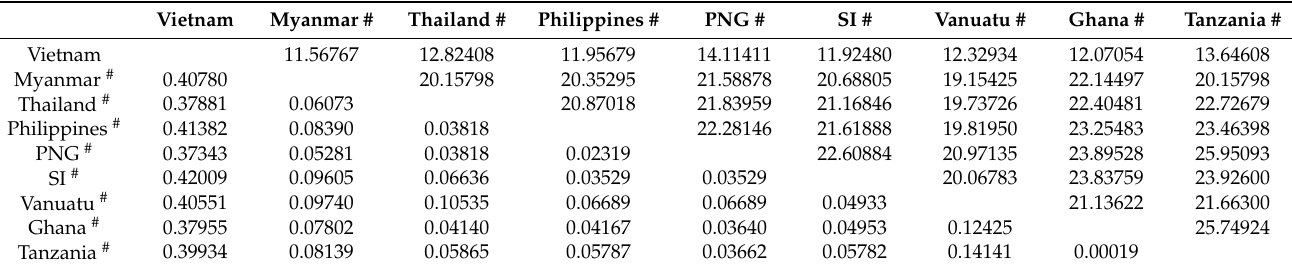
Table 4. Pair-wise F ST estimates for global